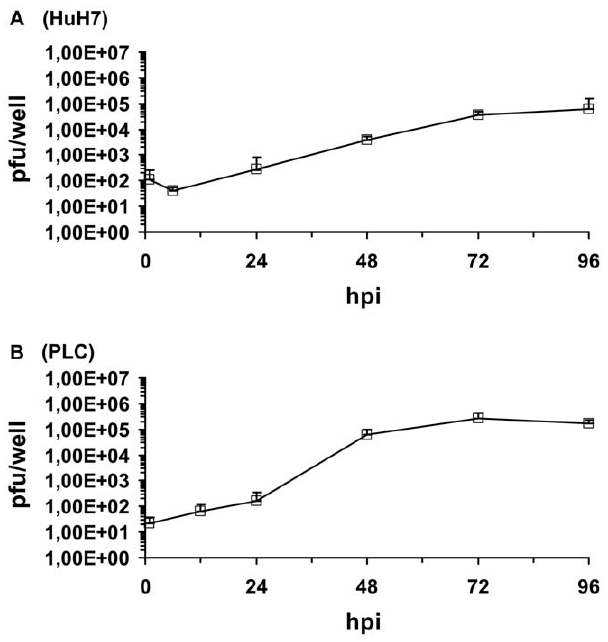
Figure 1. Replication efficiency of vaccinia virus strain GLV- 1h68 in HuH7 (A) and PLC (B) cells at an MOI of 0.1. Supernatants were collected from virus-infected cells at various time points (hours) post-infection (hpi). Viral titers were determined as pfu per well in triplicates. Averages plus standard deviation are plotted.